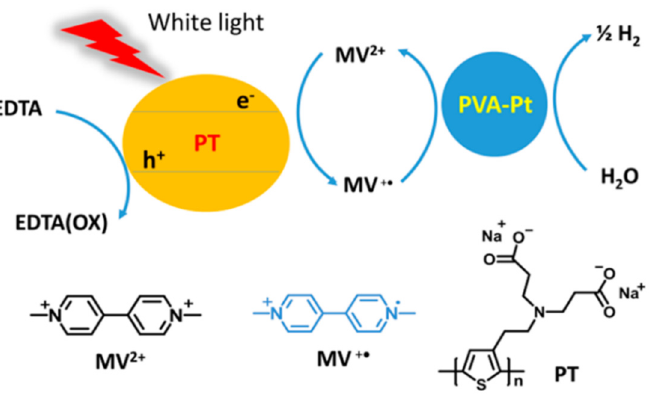
Figure 17. Photocatalytic system using anionic poly(thiophene), methyl viologen, and PVA-platinum for sacrificial hydrogen production from water. Reprinted with permission from [108]. Copyright 2017 American Chemical Society.